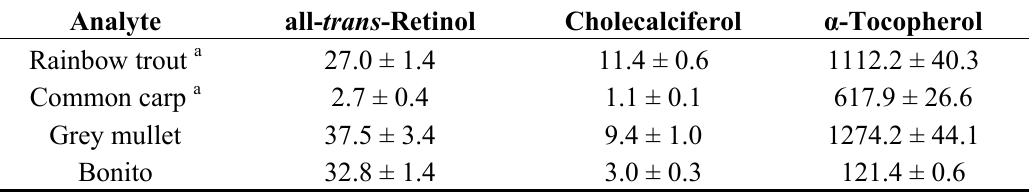
Table 2. Vitamin contents in raw fish tissue, µg/100 g ww (mean ±